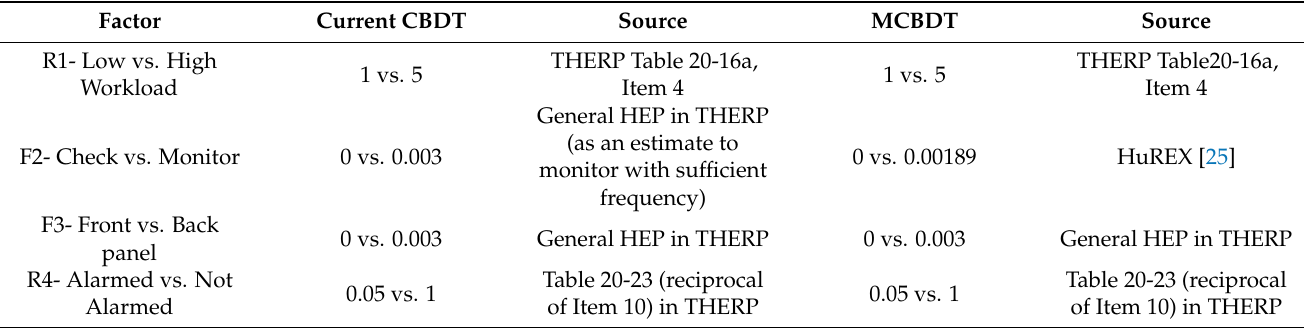
Table 4. Pcb evaluation HEPs in MCBDT and their